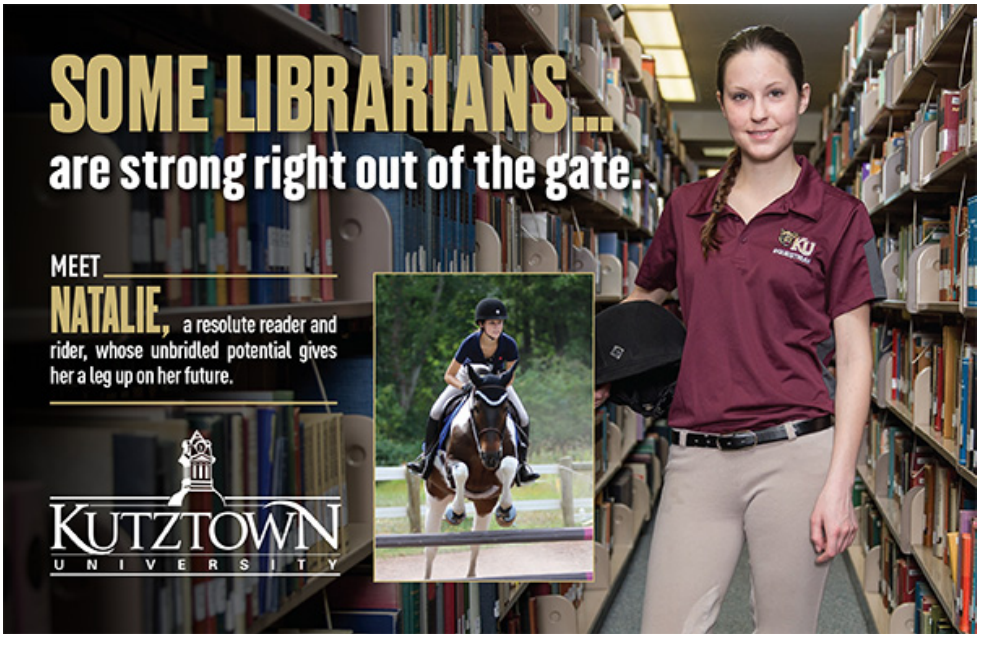
Figure 2 The two additional student profiles featured in the second Facebook